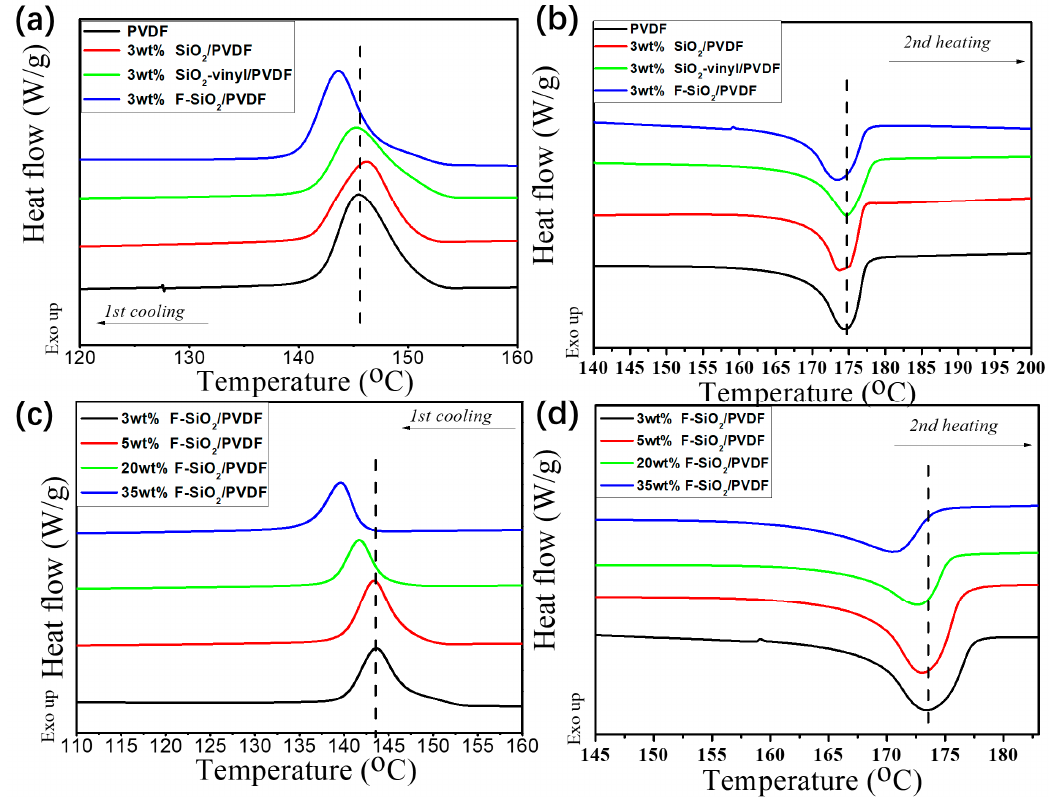
Figure 9. DSC spectra of 1st cooling ( a ) and 2nd heating ( b ) of the PVDF matrix incorporated with 3 wt% SiO 2 , SiO 2 -vinyl, and F-SiO 2 nanoparticles, respectively. DSC spectra of first cooling ( c ) and second heating ( d ) of the PVDF matrix incorporated with 3 wt%, 5 wt%, 20 wt%, and 35 wt% F-SiO 2 nanoparticles,